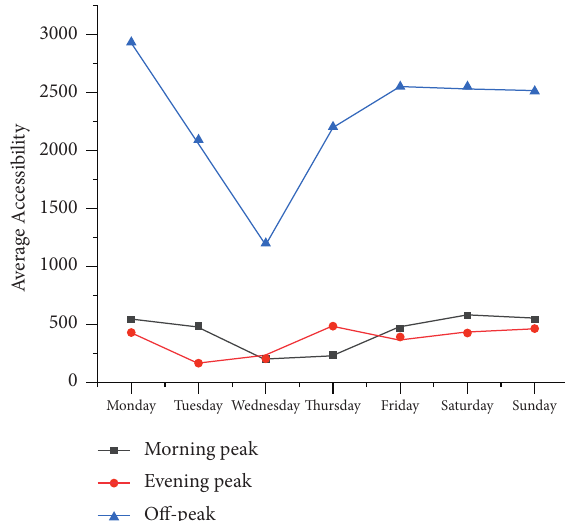
Figure 10: Time differences in